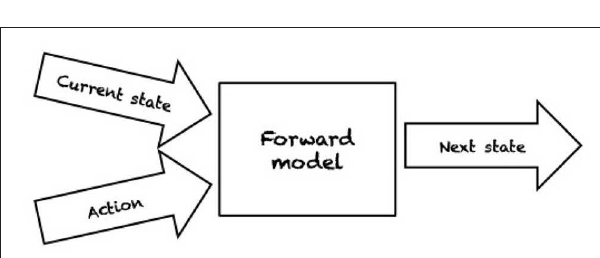
FIGURE 2 | A forward model makes a prediction on how an action will affect the current state of the environment by returning the configuration after the action is